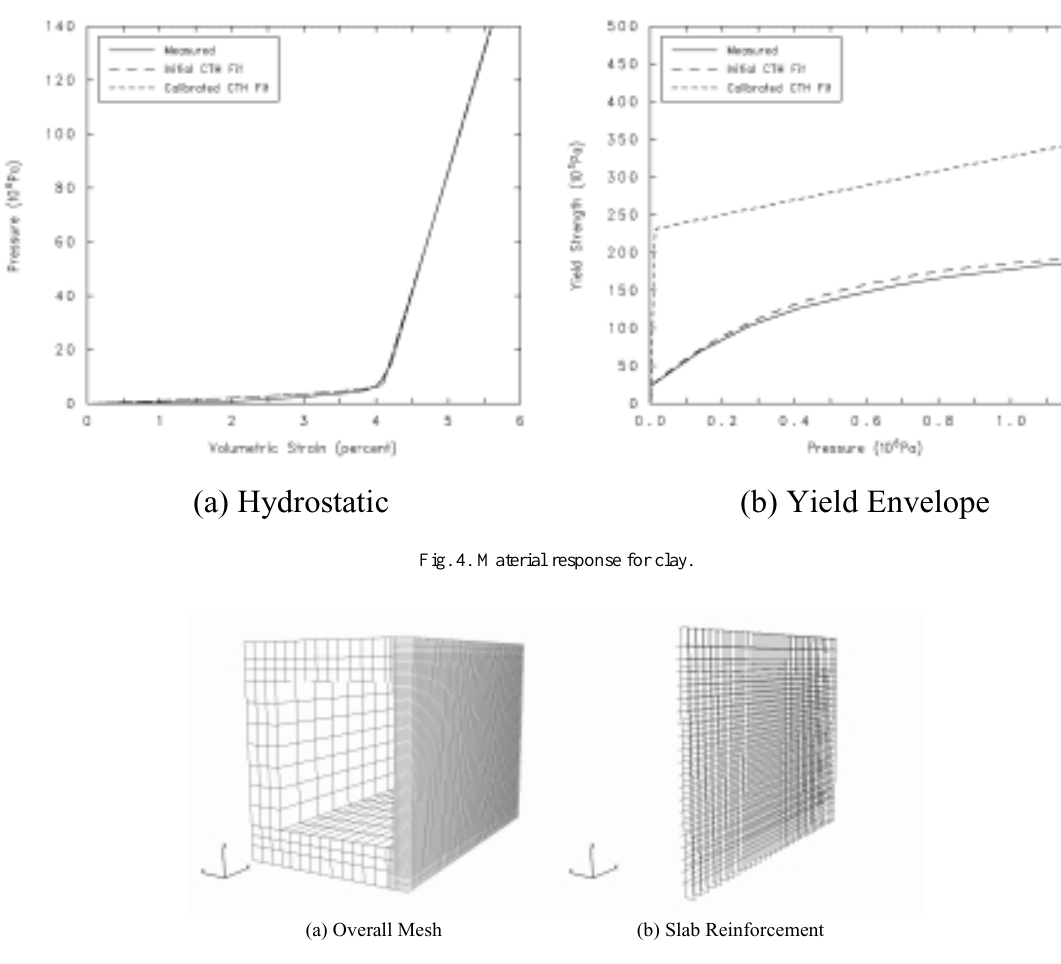
Fig. 5. FE model of the